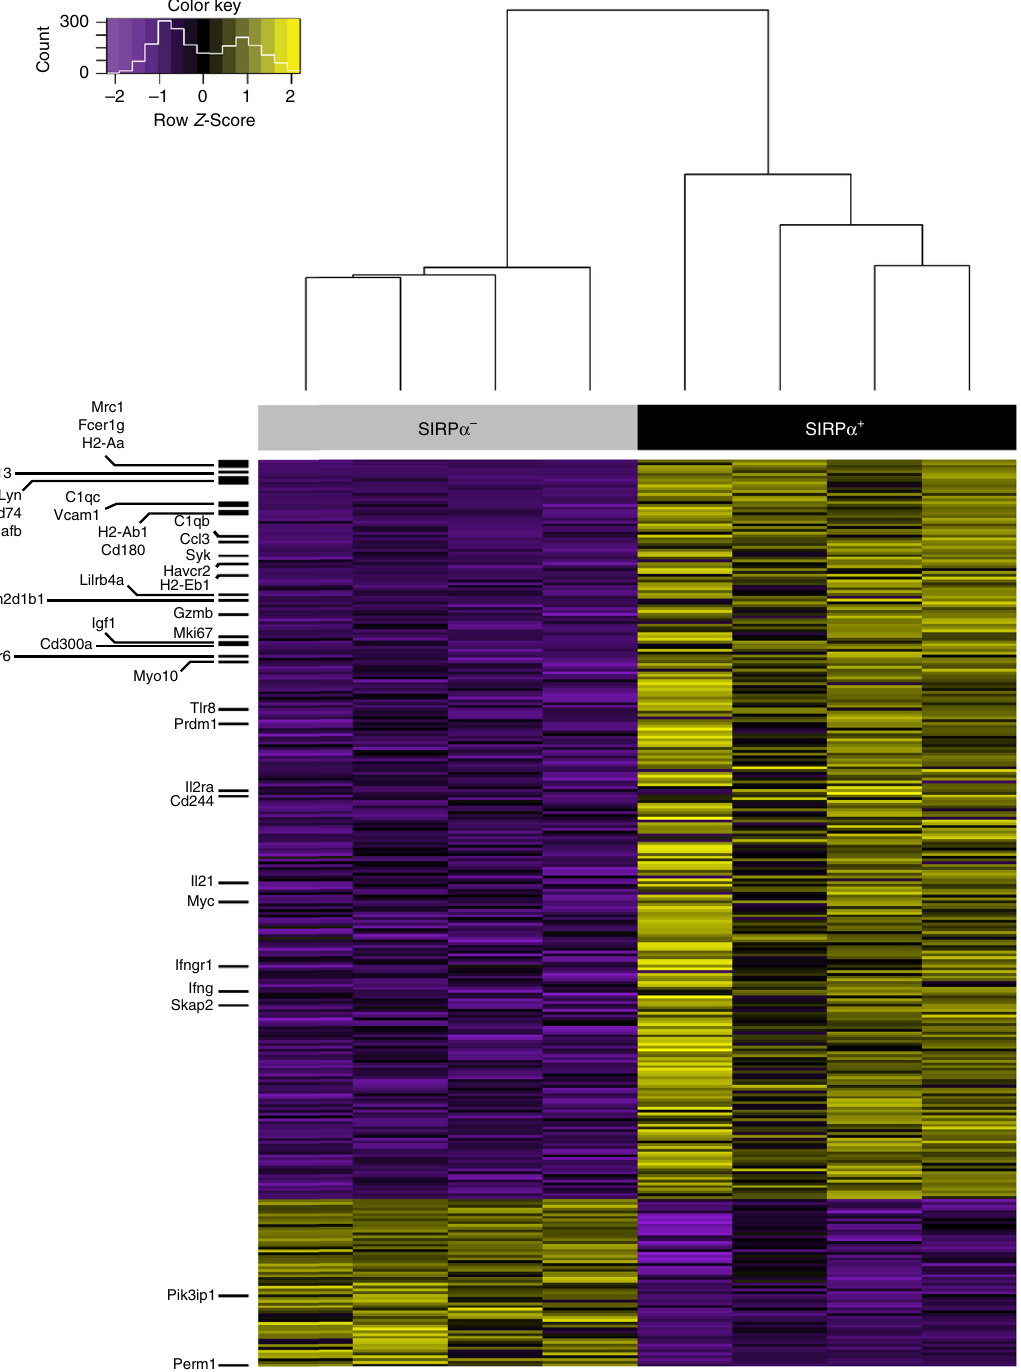
Fig. 4 Differential gene expression of bulk sorted SIRP α − or SIRP α + transgenic CD8 + PD-1 + T cells. CD8 + T cells from naive Friend virus (FV)-speci fi c Thy1.1 + CD8.TCR transgenic mice were transferred i.v. into Y10 mice chronically infected with FV. After 13 – 15 days, CD8 + cells were puri fi ed from the spleens of these recipients using anti-CD8 paramagnetic beads and the Miltenyi MACS systems. Cells were then stained with anti-Thy1.1; anti-CD8; anti- PD-1; and anti-SIRP α and sorted into CD8 + Thy1.1 + PD-1 + SIRP α − and CD8 + Thy1.1 + PD-1 + SIRP α + populations for analysis using a BD FACSAriaIIu. A heat map representation of the top 325 differentially expressed genes between the SIRP α − and SIRP α + transgenic CD8 + PD-1 + T cells was generated using the Benjamini – Hochberg procedure to decrease the false discovery rate (FDR) using DESeq2 default settings (FDR ≤ 0.1). Selected differentially expressed genes are highlighted on the left. Heat map is color coded by row z -score as shown human peripheral blood mononuclear cells (PBMCs) with anti- CD3 and anti-CD28 for 5 days led to signi fi cant upregulation of SIRP α on proliferating CD8 + T cells in comparison to unsti- mulated controls (Supplementary Fig. 5d, e). NATURE COMMUNICATIONS| (2019) 10:794